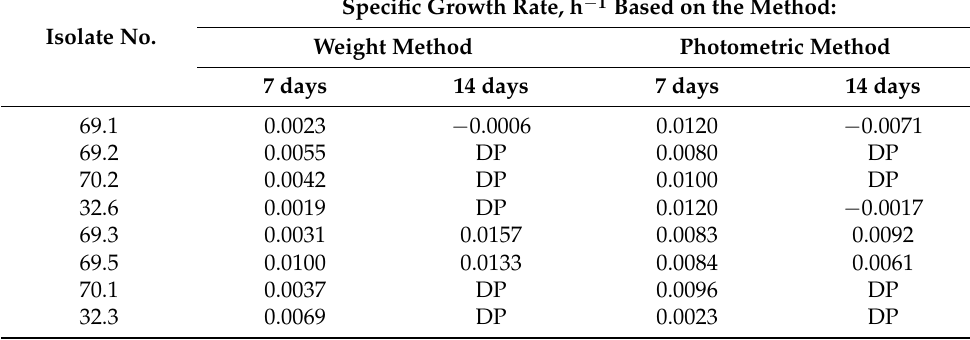
Table 1. Specific growth rates of the investigated microorganisms. Specific Growth Rate, h − 1 Based on the Method: Isolate No. Weight